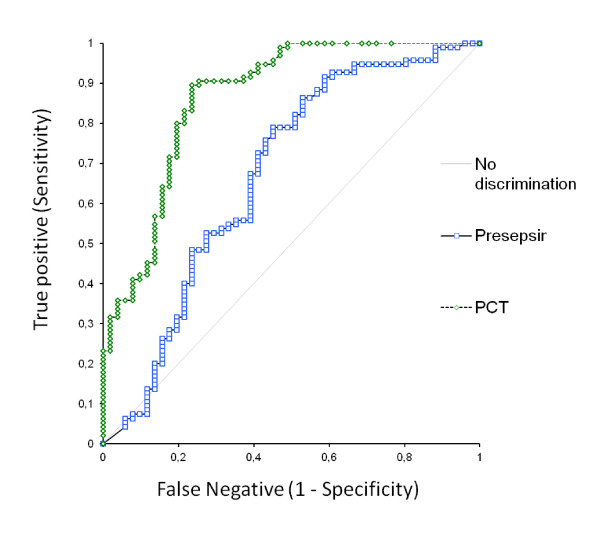
Receiver operating characteristic curve for presepsin (blue) and procalcitonin (green) in patients with definitive diagnosis of sepsis, severe sepsis or septic shock. Areas under the curve were 0.70 for presepsin (P < 0.001) and 0.87 for procalcitonin (P < 0.001).{AU: Please fix misspelling "Presepsina" to "Presepsin" in figure. See attached file for figure 1}